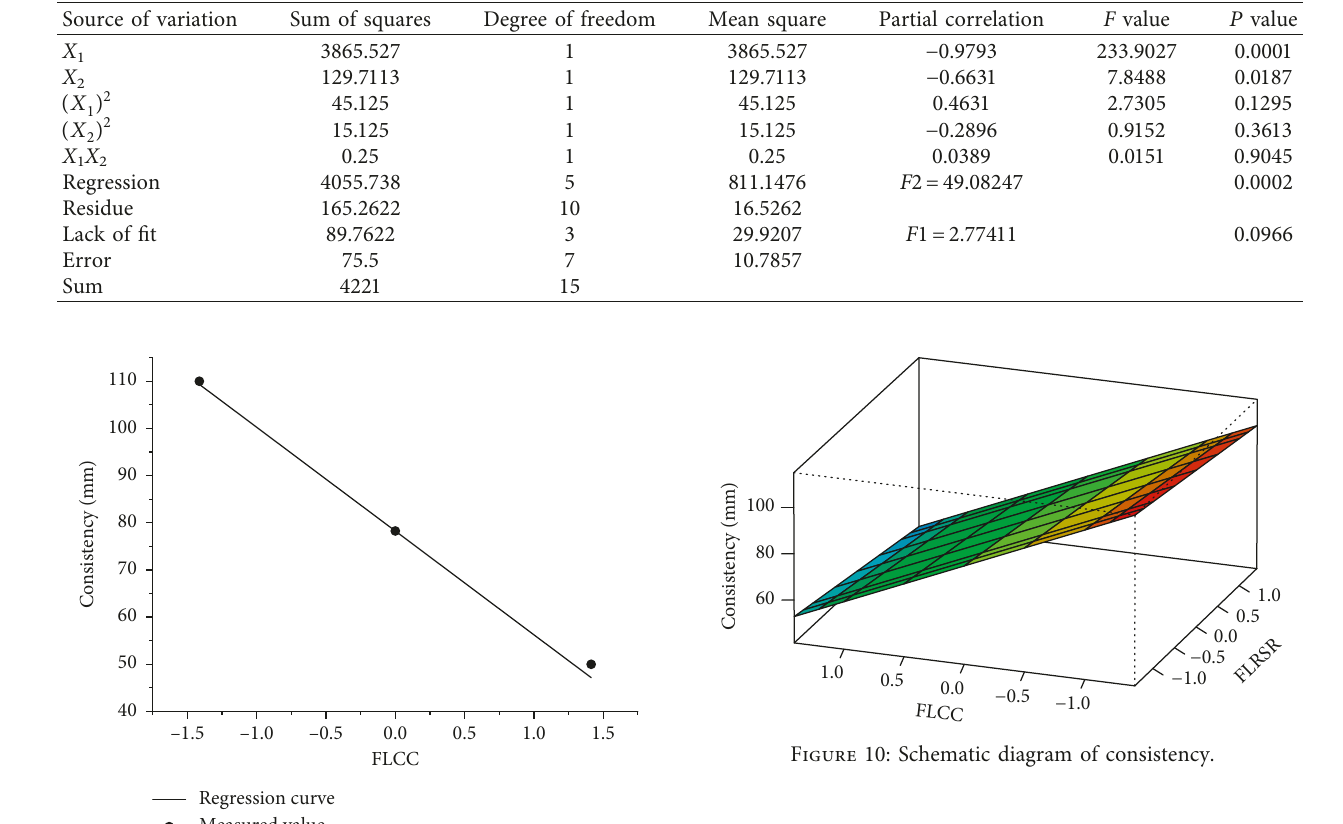
Table 9: Variance analysis of consistency of mortar.